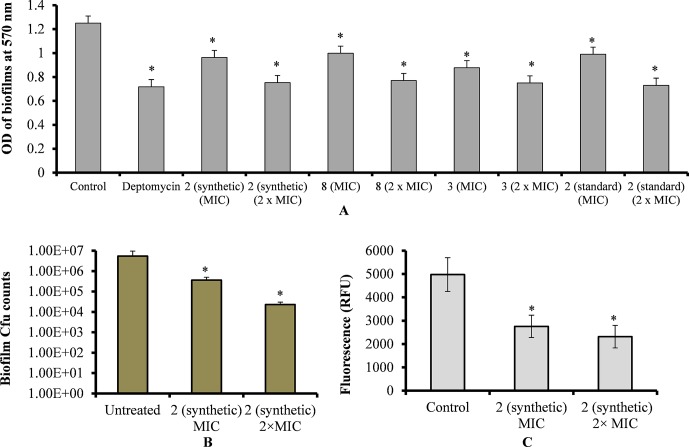
Effect of viniferins on pre-established biofilms of S. pneumoniae. (A) Treatment of pre-established biofilm with MIC and 2 × MIC of viniferins and biofilm biomass was quantified via CV microplate assay. (B) Treatment of pre-established biofilm with MIC and 2 × MIC of ε-viniferin (2) and viable bacteria detected by cfu counts. (C) Metabolically active bacteria within biofilms treated with MIC and 2 × MIC of ε-viniferin (2) via resazurin staining. The error bars represent standard deviations. Statistical significance was calculated by Student’s t-test, and * = p < 0.05 was considered significant.